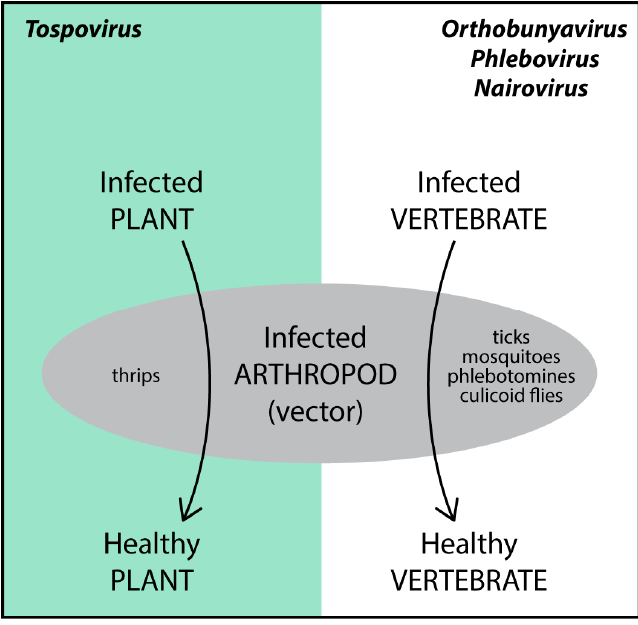
Figure 1. Bunyaviruses and their arthropod vectors.